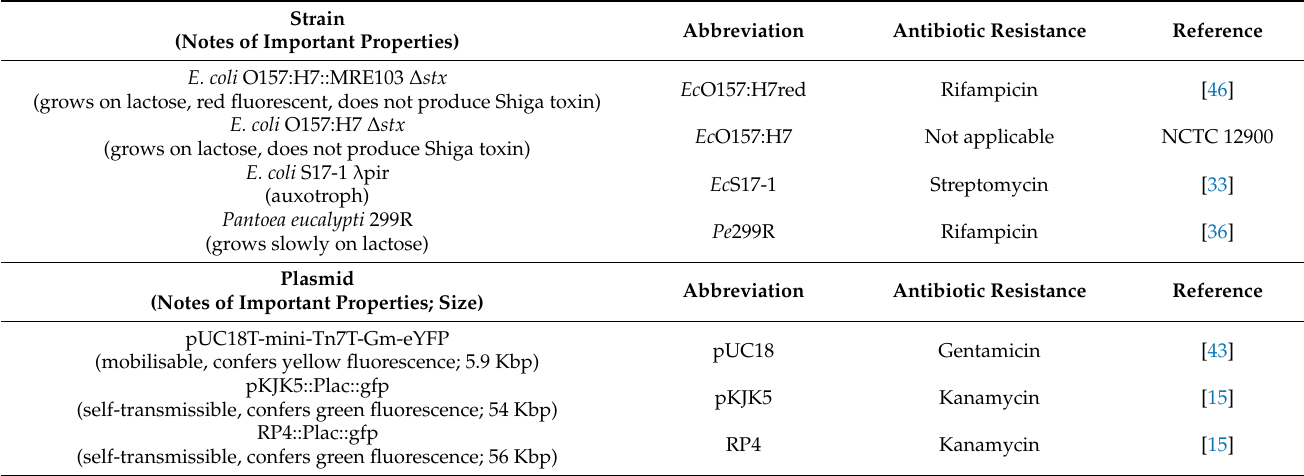
Table 1. Strains and plasmids used in this study and their